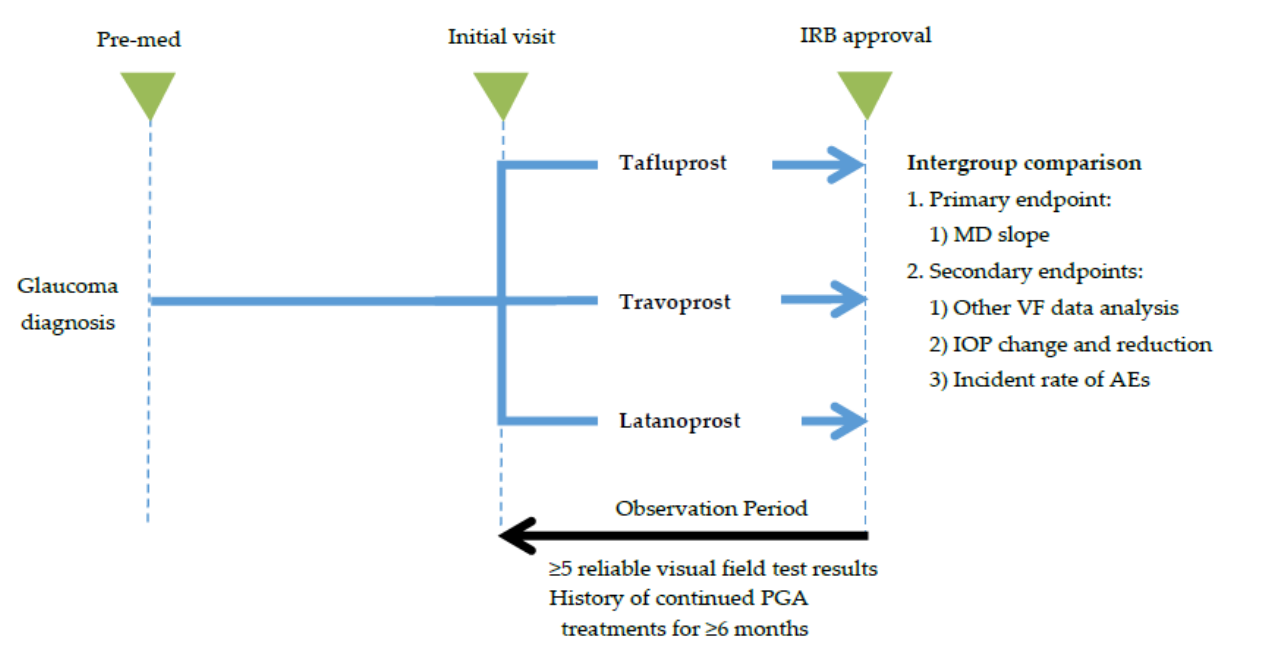
Figure 1. Study Figure 1. Study flow.